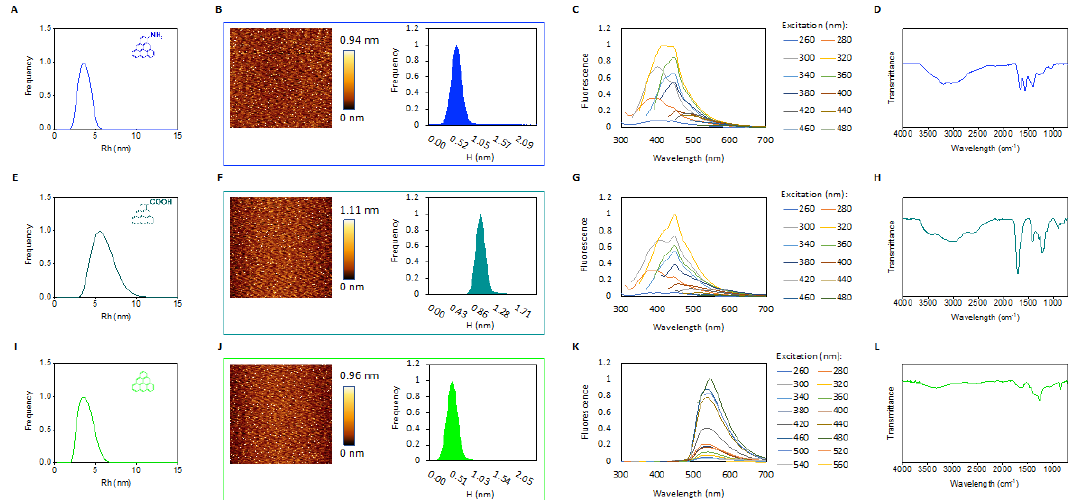
Figure 1. Characterization of the three functionalized graphene quantum dots (GQDs). Dynamic light scattering (DLS), atomic force microscopy (AFM imaging, height distribution, fluorescence spectra and Fourier transform infrared spectroscopy (FTIR) spectra of NH 2 -GQDs ( A – D ), COOH-GQDs ( E – H ) and Green-GQDs ( I – L ).